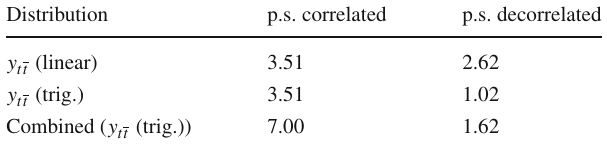
Table 3 χ 2 / N data values for fits to the ATLAS 8 TeV lepton + jet rapidity distributions, including decorrelation of the parton shower sys- tematic uncertainty described in the text